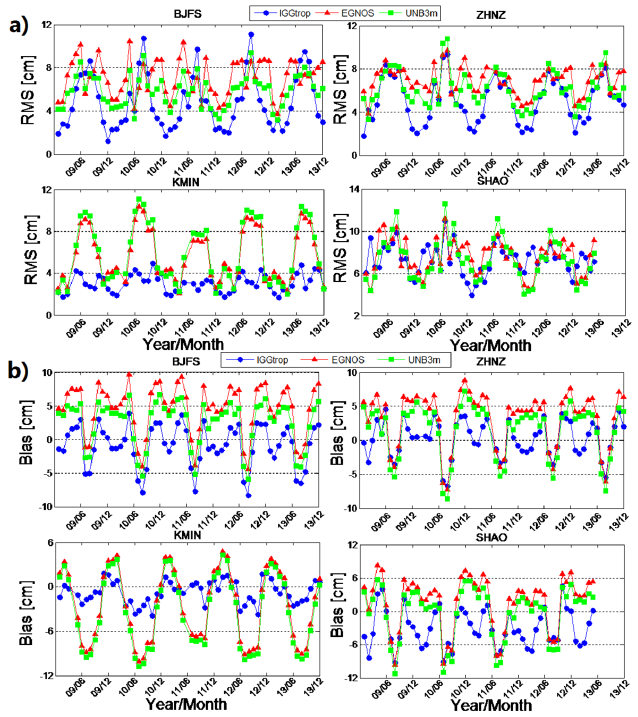
Figure 4. Temporal variations of monthly mean RMS ( a ) and Bias ( b ) for the IGGtrop, EGNOS and UNB3m models at four exemplary stations of BJFS, ZHNZ, KMIN and SHAO. UNB3m models at four exemplary stations of BJFS, ZHNZ, KMIN and SHAO.